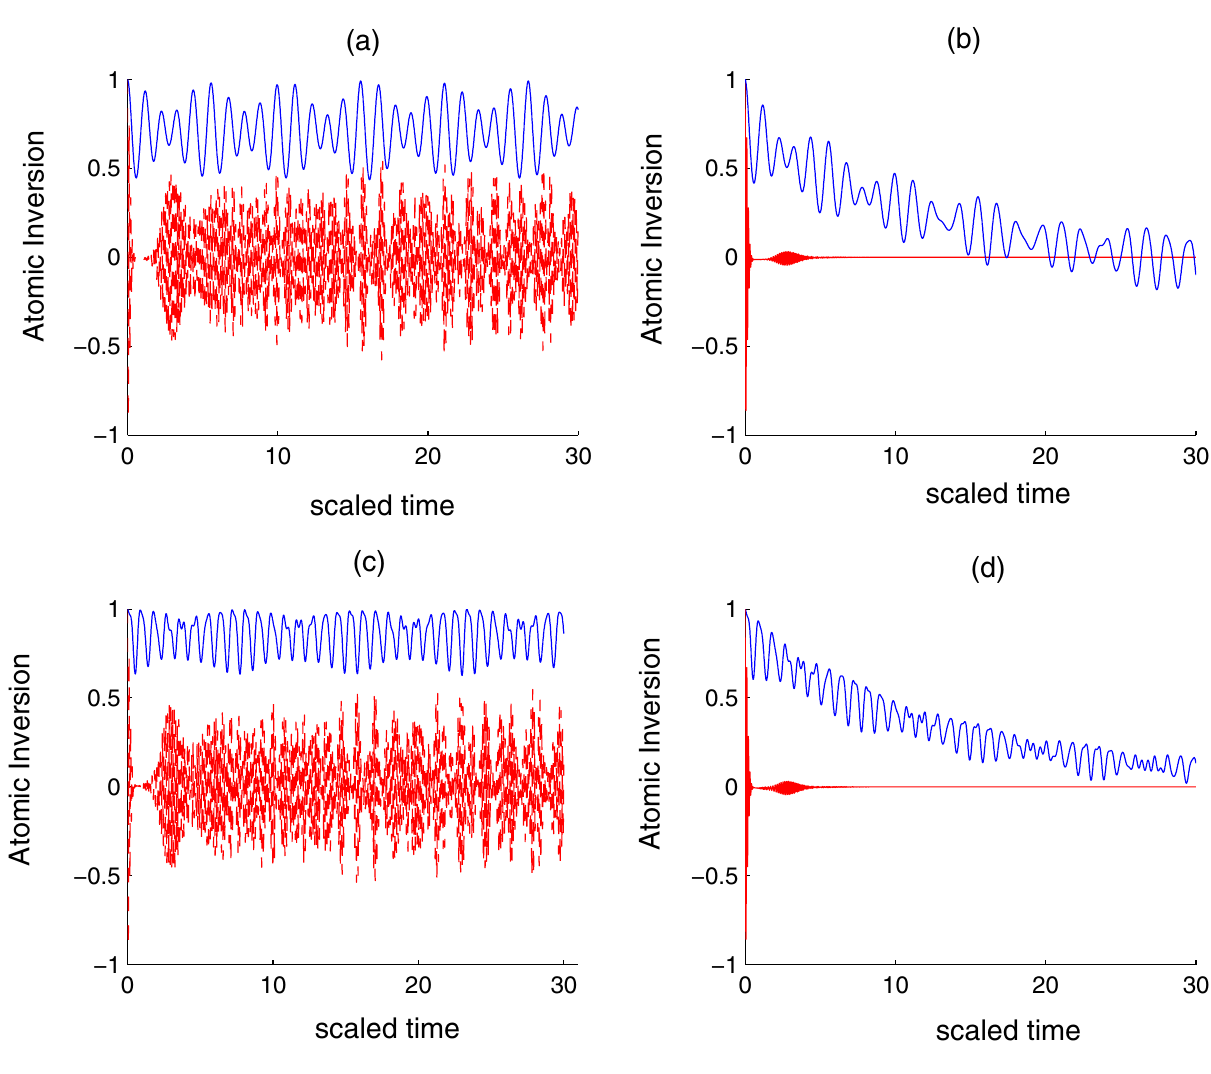
Figure 1. Time evolution of the atomic inversion W ( t ) for � = π/ 2 and � = π/ 4 . ( a ) is for ( j = 2 blue line, j = 40 red line and the absence of atom-atom coupling R = 0 ). ( c ) is for (red line j = 2 , red line j = 40 , and the presence of atom-atom coupling R = 5 (cid:31) . ( b , d ) are the same as ( a , c ) under the field dissipation effect rate γ = 0.01 (cid:31)